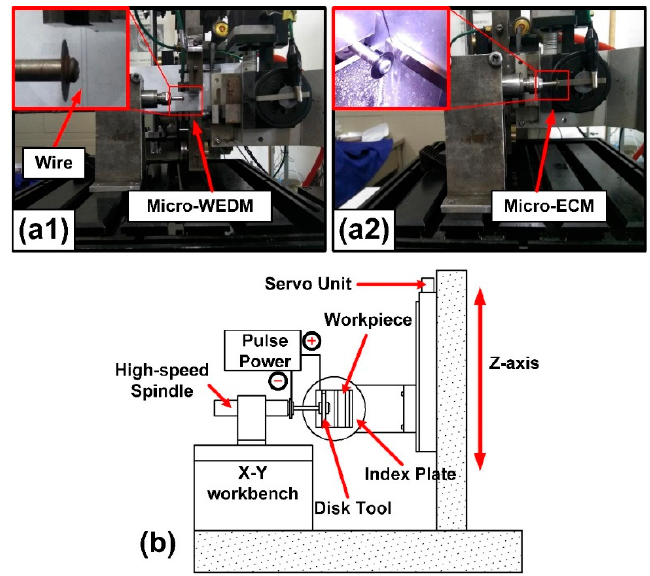
Figure 1. ( a1 , a2 ) Photographs of the micro wire electrical discharge machining (micro-WEDM) machine with high precision micro-electrochemical milling device. ( b ) The device diagram of the micro-electrochemical milling module.